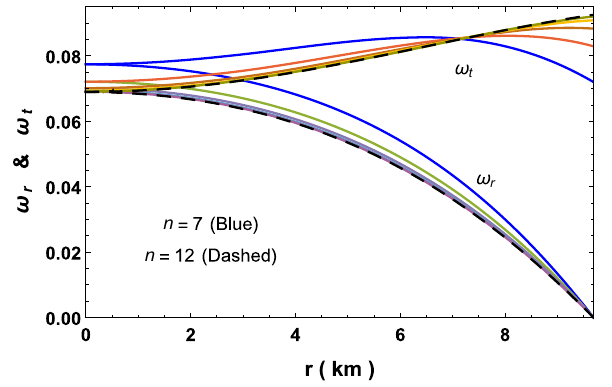
Fig. 5 Equation of state parameter profiles of PSR J1614-2230 for M = 1 . 97 M (cid:6) , R = 9 . 69 km and b = 0 . 04